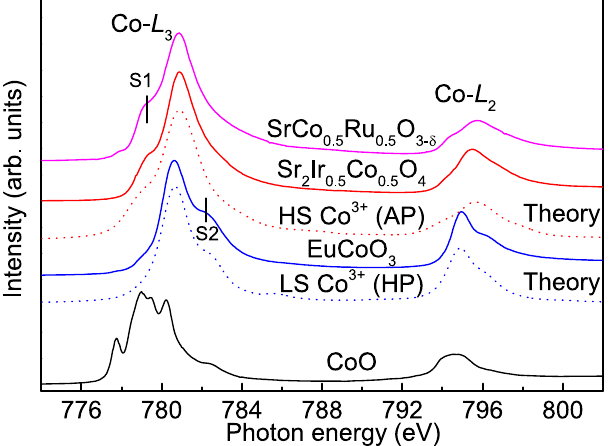
Figure 1. Co- L 2,3 absorption spectra of Sr 2 Co 0.5 Ir 0.5 O 4 together with EuCoO 3 as a LS-Co 3 + ref. 24, SrCo 0.5 Ru 0.5 O 3- δ as a HS-Co 3 + ref. 29, and CoO as a HS-Co 2 + reference. The theoretical spectra of HS Co 3 + below Sr 2 Co 0.5 Ir 0.5 O 4 and LS Co 3 + below EuCoO 3 are also included for